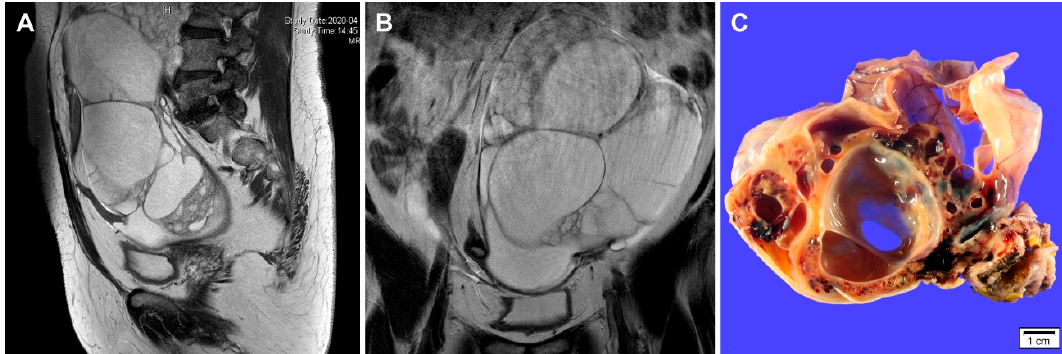
Figure 1. Imaging and gross findings of gynandroblastoma. ( A , B ) a 65-year-old woman presented with an abdominal mass. Abdominopelvic magnetic resonance imaging reveals a 20 cm multiseptated cystic mass arising from the left ovary. No evidence of abdominopelvic peritoneal seeding, lymph node enlargement, or hematogenous metastasis is identified. Preoperative laboratory test showed a slight elevation of serum CA 125 level (37.1 U/mL). The serum CA 19-9 level was within normal range (32.1 U/mL). ( C ) Grossly, the cut section of the ovarian tumor shows variable-sized, thin-walled cystic spaces. Solid areas show yellow-to-tan tumor tissue with hemorrhagic spots. The inner surface of cystic lesions is relatively smooth and glistening.